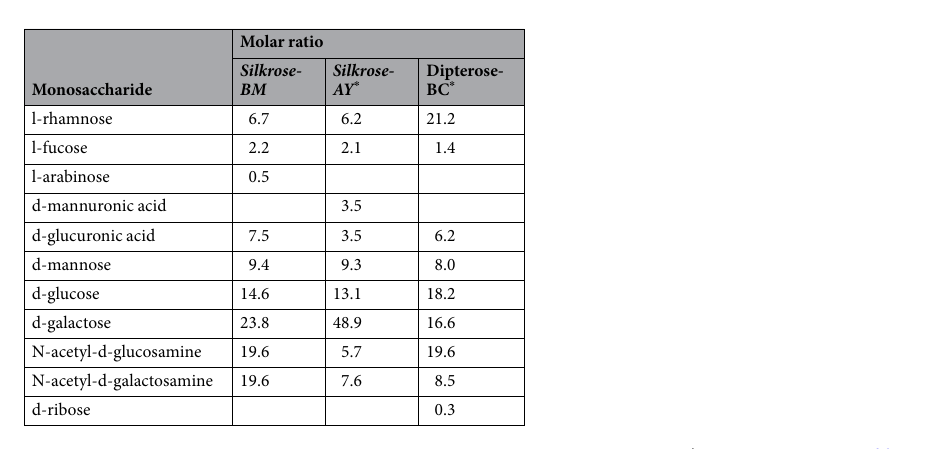
Table 2. Molar ratios of monosaccharides in the purified polysaccharides. * Based on Ohta et al . 8,9